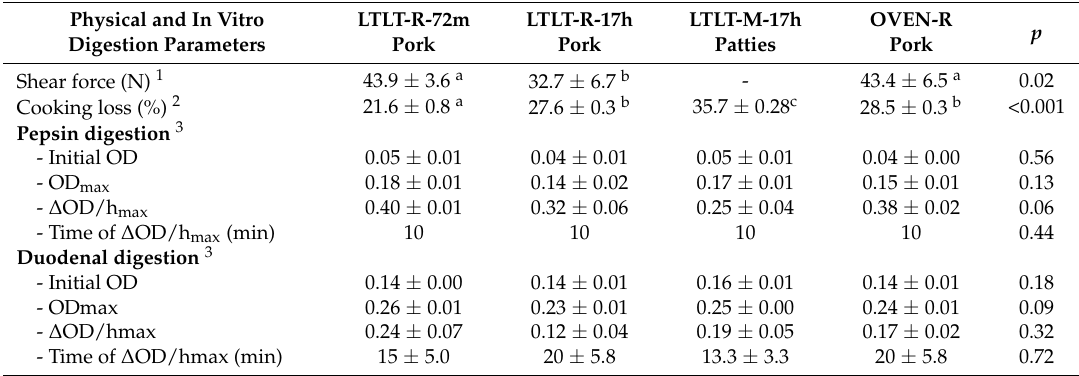
Table 2. Physical and in vitro digestion parameters of cooked porcine M. Semitendinosus used in the appetite study (mean ± SEM unless otherwise specified).